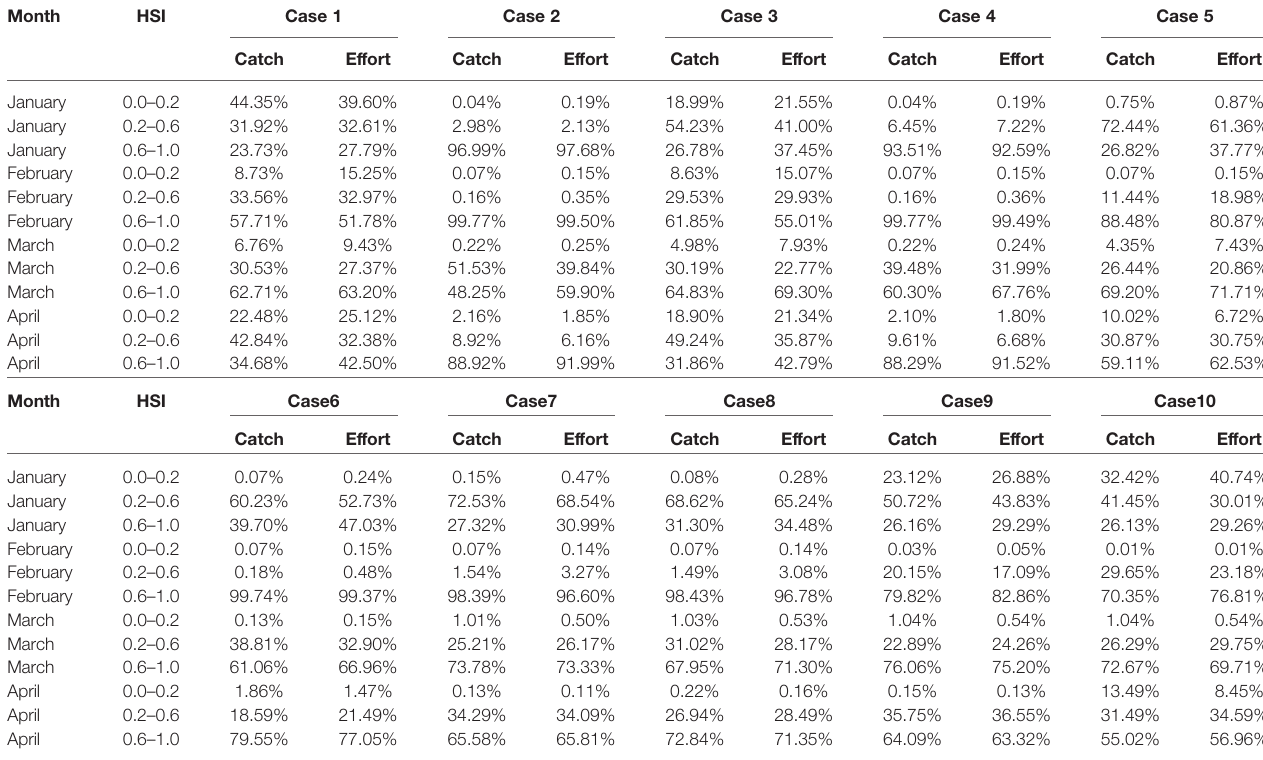
TABLE 3 | Percentage of catch and effort under different HSI class interval sourced from different weighting model during 2013 –